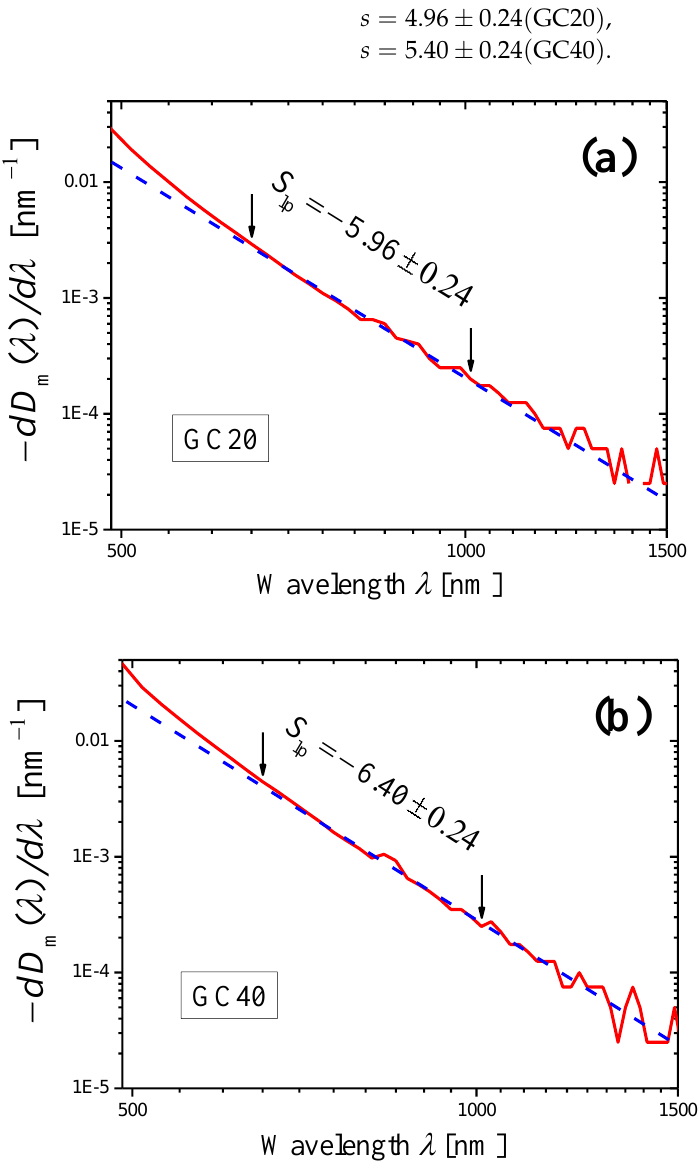
Figure 11. Log–log plots of the dependences of ( − dD i m ( λ ) / d λ ) on λ (red curves) constructed for the measured optical densities D m ( λ ) of samples of the glass-ceramics GC20 ( a ) and GC40 ( b ). Notice that the spectral range is wider than in Figure 6 for the same glass-ceramics; the wavelength step ∆ λ = 20 nm is greater than the step ∆ λ = 1 nm used to draw the curves in Figure 6. 3.2. On the Choice of the Wavelength Step in the Spectrum of the Measured Optical Density Basing on the results presented in Section 3.1, we can conclude that the novel method leads to correct values of the scattering exponent for the glass-ceramics GC20 and GC40 if it is applied in the proper wavelength range, and the proper wavelength step is chosen. The problem of the choice of the wavelength step was also discussed in Section 2.2.4 for the MAS-GC.